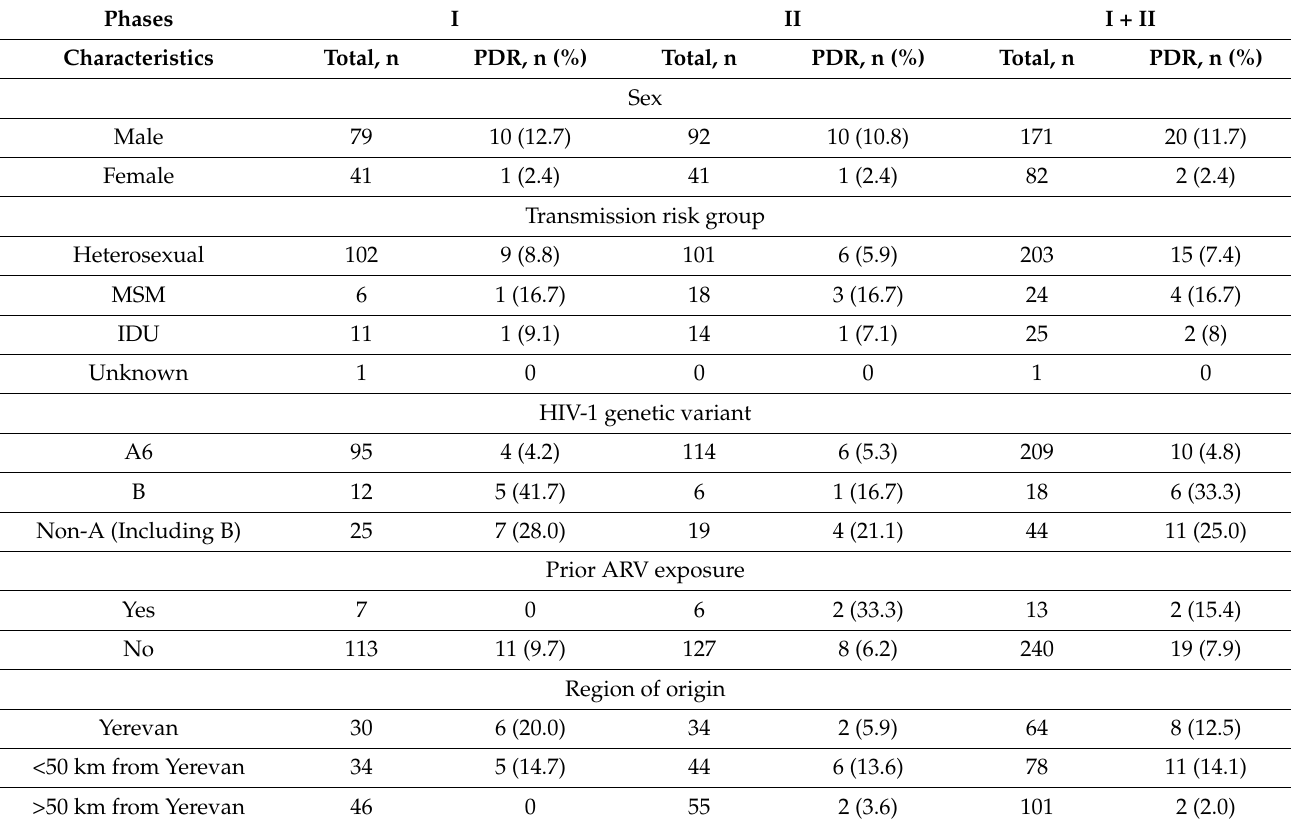
Table 3. Prevalence of PDR in the study population stratified by different